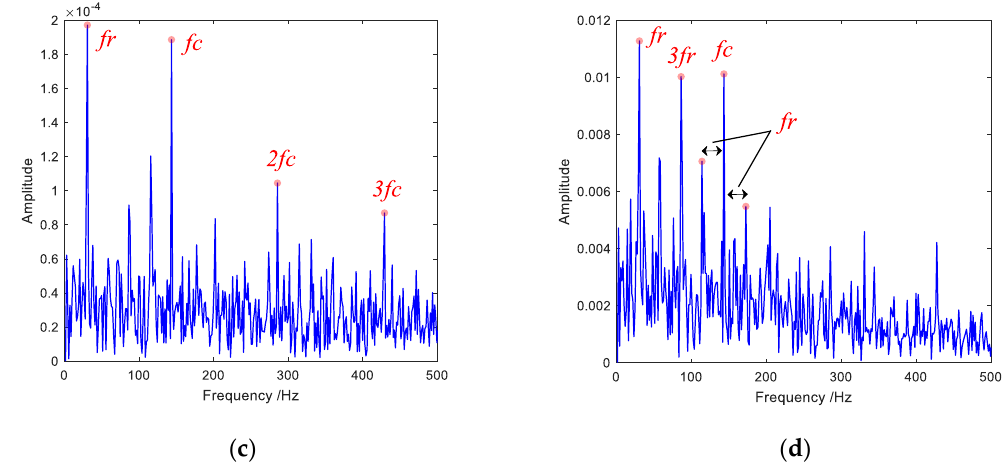
Figure 16. Results of feature extraction of reconstructed TFD 2 (dominant frequency band—around 3200 Hz) and TFD 3 (dominant frequency band—within 1000 Hz): ( a ) Envelope waveform of TFD 2; ( c ) envelope spectrum of TFD 2; ( b ) envelope waveform of TFD 3; ( d ) envelope spectrum of TFD 3.